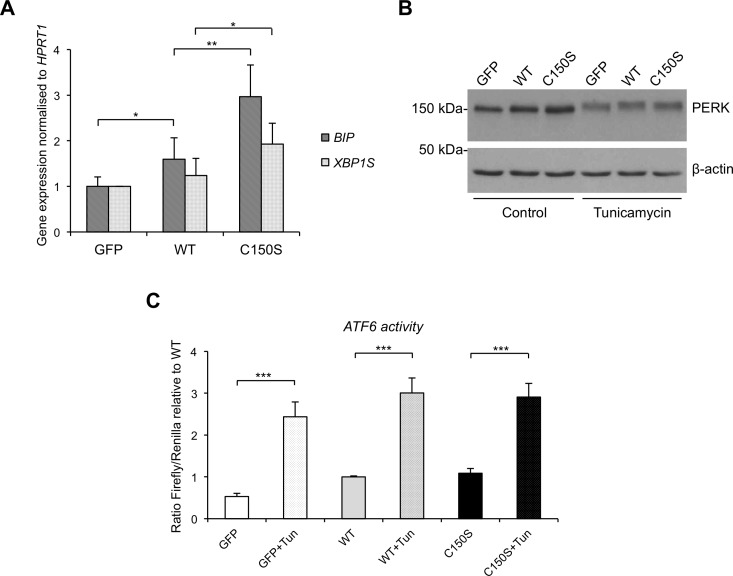
UPR induction in MDCK cells expressing wild type or C150S uromodulin isoforms.(A) BIP and XBP1S expression assessed by real-time RT-qPCR. Expression is normalised to HPRT1. *P<0.05, **P<0.01 (Student t test) (n = 5 independent experiments). (B) Western blot analysis of PERK in MDCK cells expressing wild type or C150S mutant uromodulin. A shift in PERK migration is seen upon tunicamycin treatment (2 μg/mL for 14 h), but not at baseline. (C) ATF6 activation assessed through the use of an ATF6 reporter construct. No ATF6 activation is observed in mutant uromodulin expressing cells. Activation can be observed in all cell lines upon tunicamycin treatment. ***P<0.005 (control vs tunicamycin-treated, Student t test) (n = 6 independent experiments).